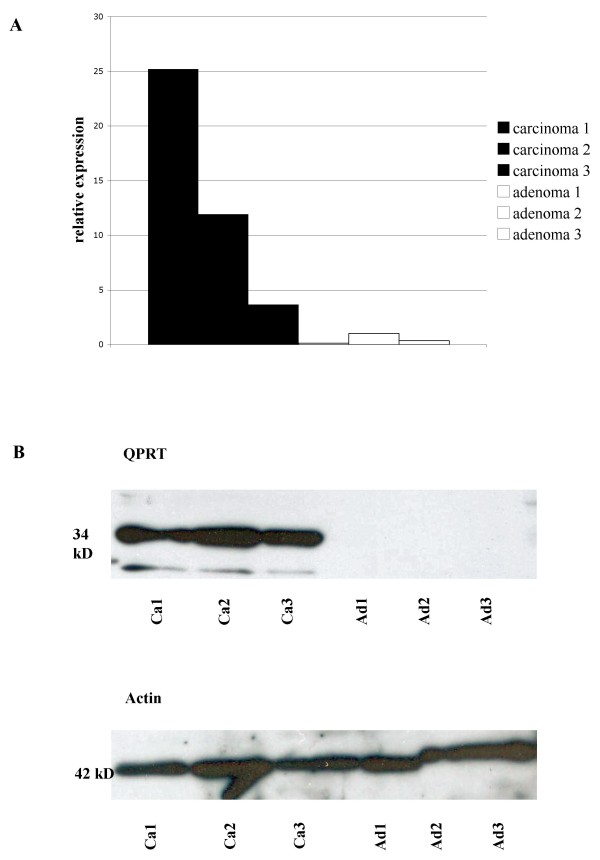
qRT-PCR (A) and western blot analysis (B) of the 3 FTA and FTC presented in figure 2. In qRT-PCR, carcinomas reveal a relative quantity of QPRT-RNA expression between 3,65 and 25,18. The relative quantity of QPRT-RNA expression in adenomas is between 0,13 and 1,00. In western blot analysis, FTC reveal a strong band at 34 kD, while follicular adenomas lack any band. Blotting with actin was performed as loading control. Ad: Adenoma; Ca: Carcinoma.